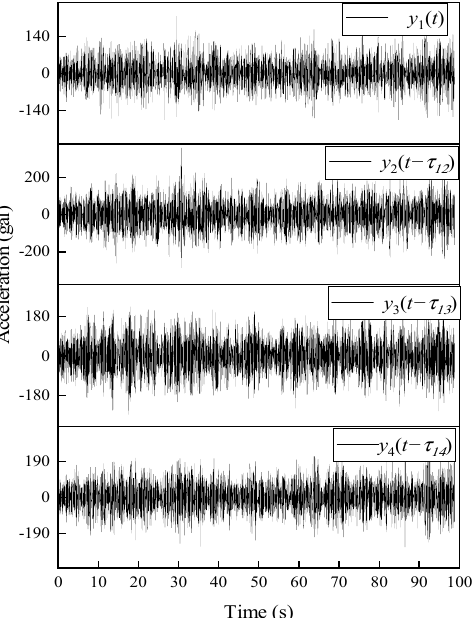
Figure 4. Artificially misaligned accelerations response of the LTI